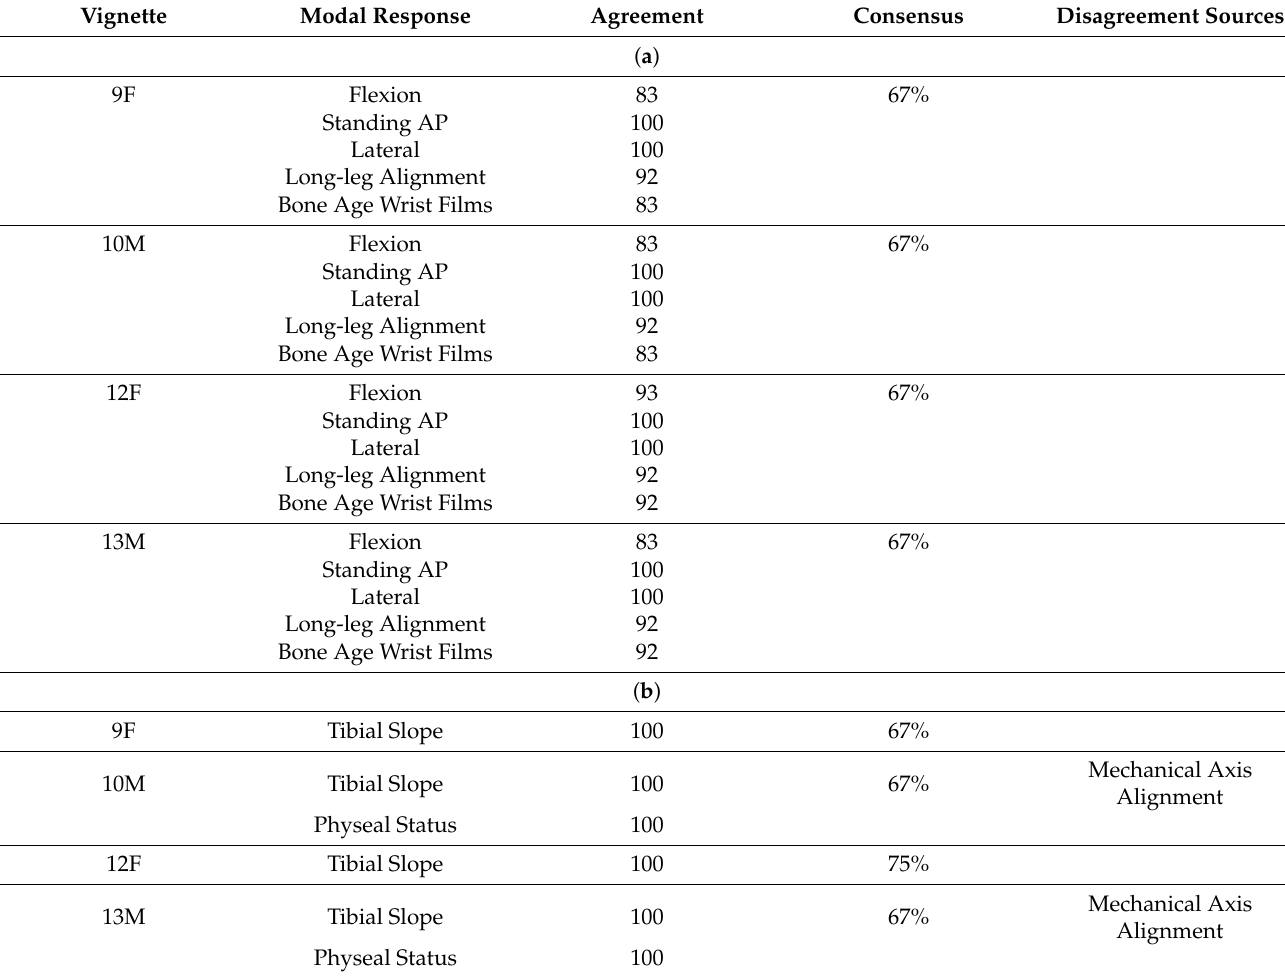
Table 3. ( a ) Consensus reached in all vignettes regarding pertinent radiographic images. ( b ) Consensus reached regarding pertinent radiographic interpretation with relevant sources of disagreement per